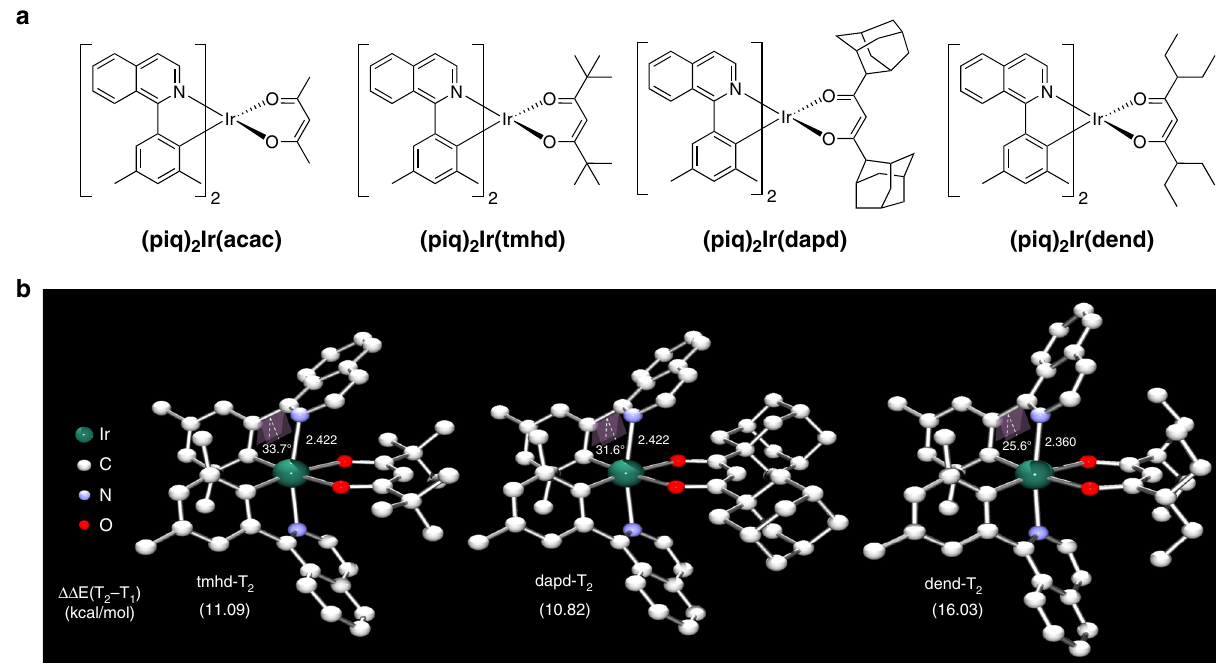
Fig. 3 Rationally designed Ir(III)-dopants. a Chemical structures of Ir(III) complexes. b DFT-optimized 3 MC state structures of (piq) 2 Ir(tmhd), (piq) 2 Ir (dapd), and (piq) 2 Ir(dend). All bond lengths are in Å.